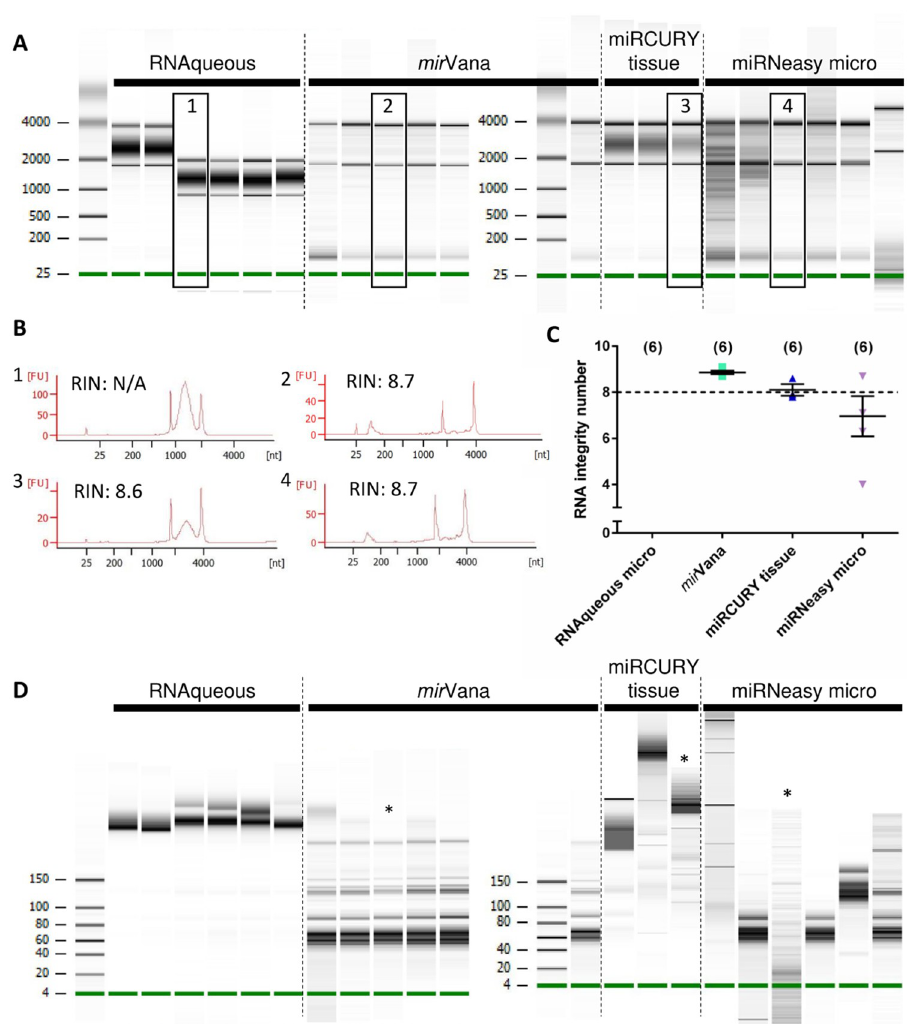
Fig 3. Capillary electrophoresis analysis of pig LV biopsy RNA. ( A) Bioanalyzer nano chip traces of all tested samples. Inspection of electropherograms provides additional information to assess RNA quality and protocol performance. (B) Representative traces from each protocol with respective RIN values. Numbers 1–4 correspond to numbered boxes in A. Note that trace 3 has a high RIN despite a large smear in the gel. (C) Summary of RIN values of all the samples tested (mean ± SEM). The RNAqueous protocol had undetectable RINs. The mir Vana and miRCURY tissue protocols gave consistently high RIN values, while despite high average RIN, the samples from the miRNeasy micro protocol are more variable. Numbers in brackets indicate the number of samples in each group. (D) Bioanalyzer small RNA chip traces for each kit. Although the RIN of samples marked � were similar (8.6–8.7), the spectrum of small RNAs recovered is highly